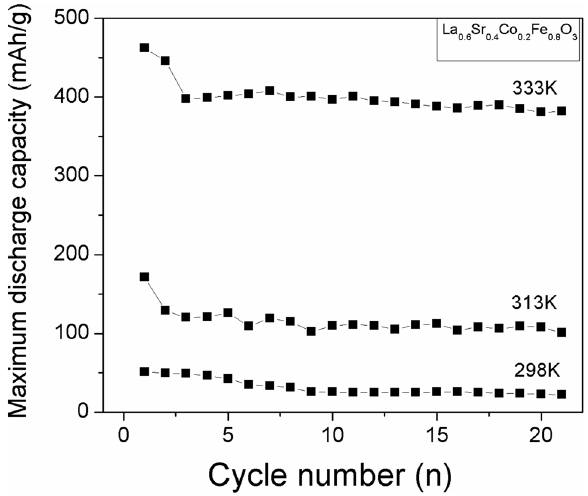
Fig. 3 Discharge capacity vs cycle number at 298, 313 and 333 K in KOH 6 M, respectively. (discharge current density of 125 mA g - 1